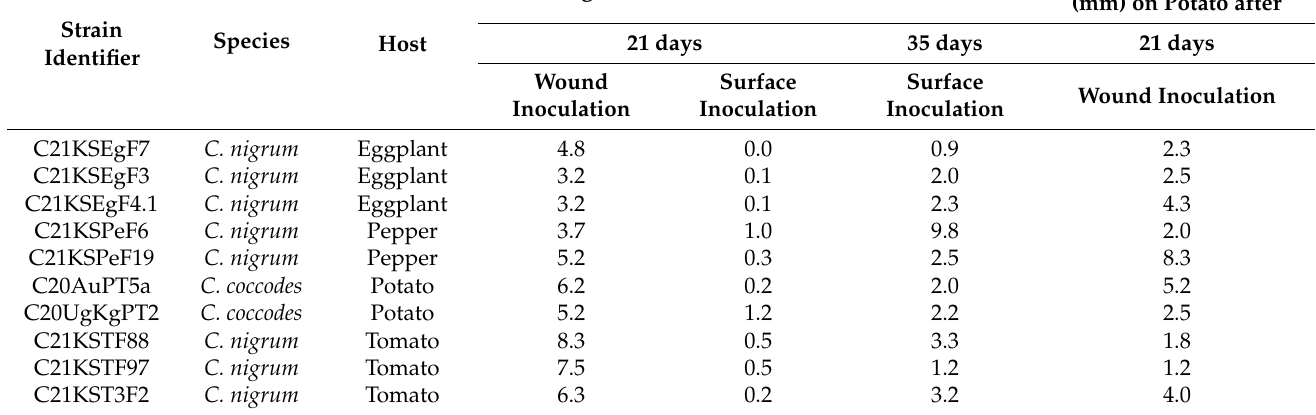
Table 4. Pathogenicity tests.